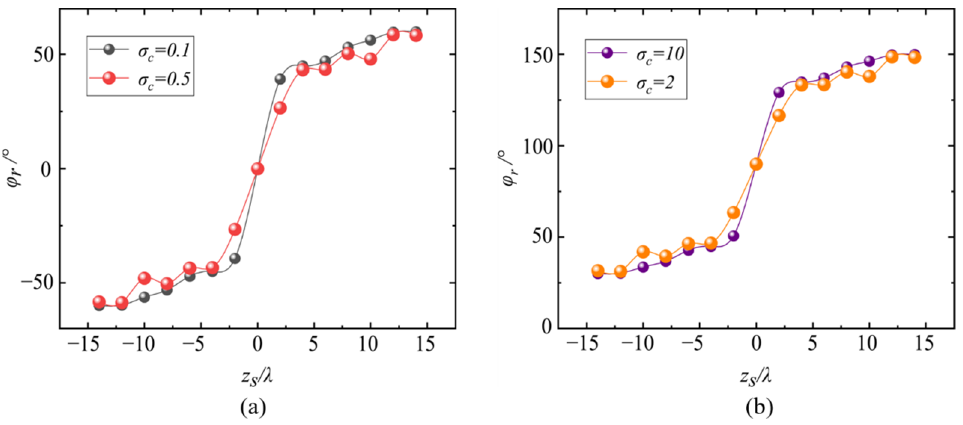
xy with the beam